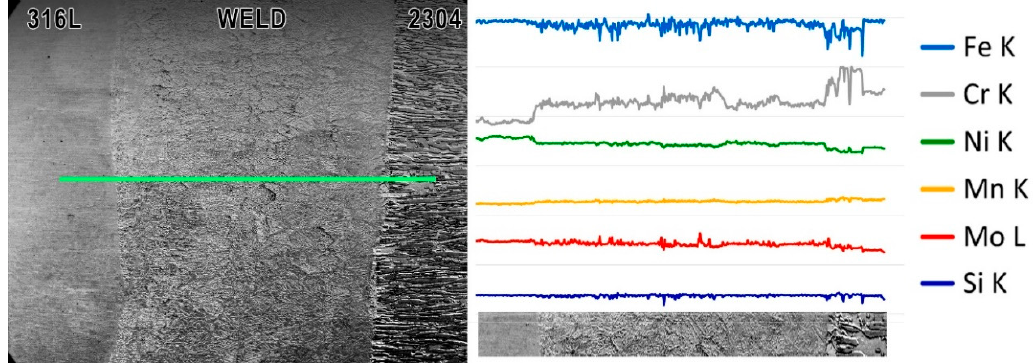
Figure 9. Results of EDS linear analysis through the welded joint from 316L austenitic stainless steel